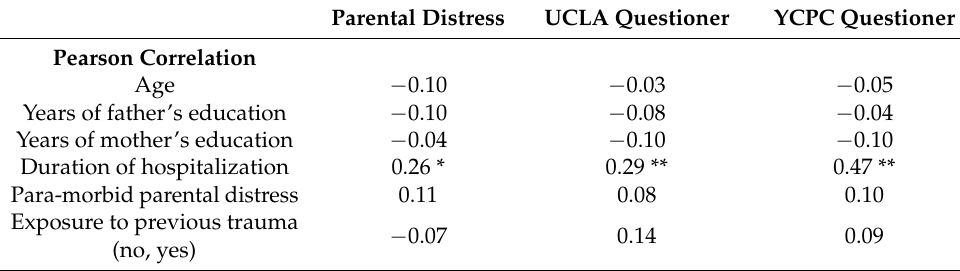
Table 2. Correlations between background variables to PDS and PTSD scores (N =